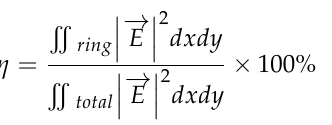
Figure 12. Power fraction as a function of frequency for different modes.